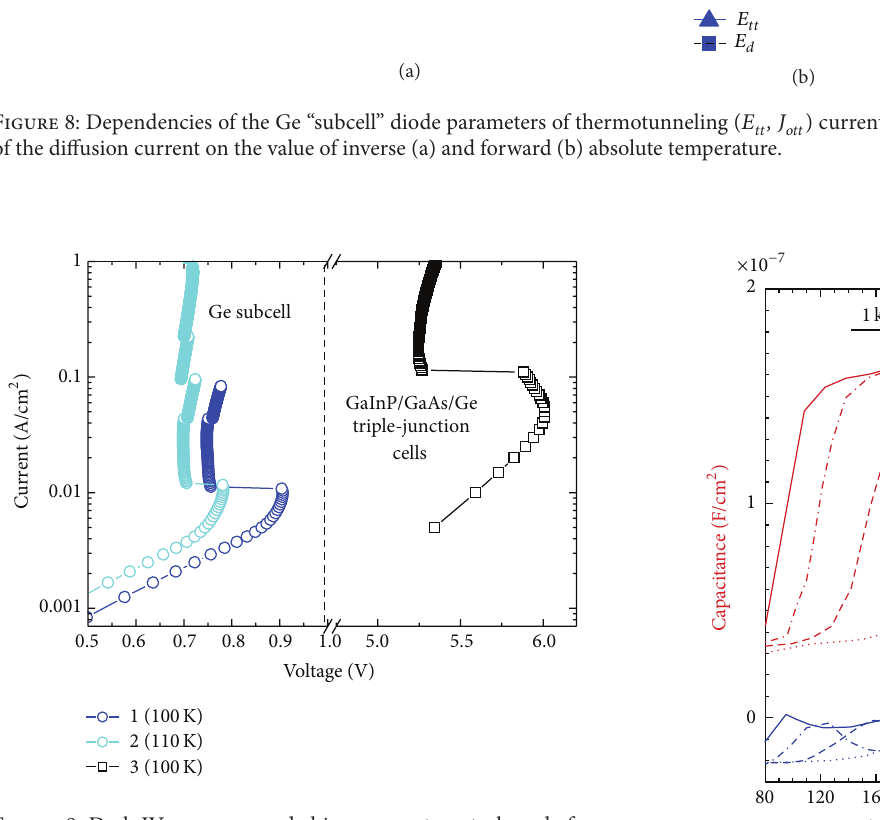
Figure 9: Dark IV curves recorded in a current control mode for the Ge “subcell” structure at 100K (1) and 110K (2), GaInP/GaAs/Ge triple-junction solar cell at 100K (3). Figure 10: C - T -